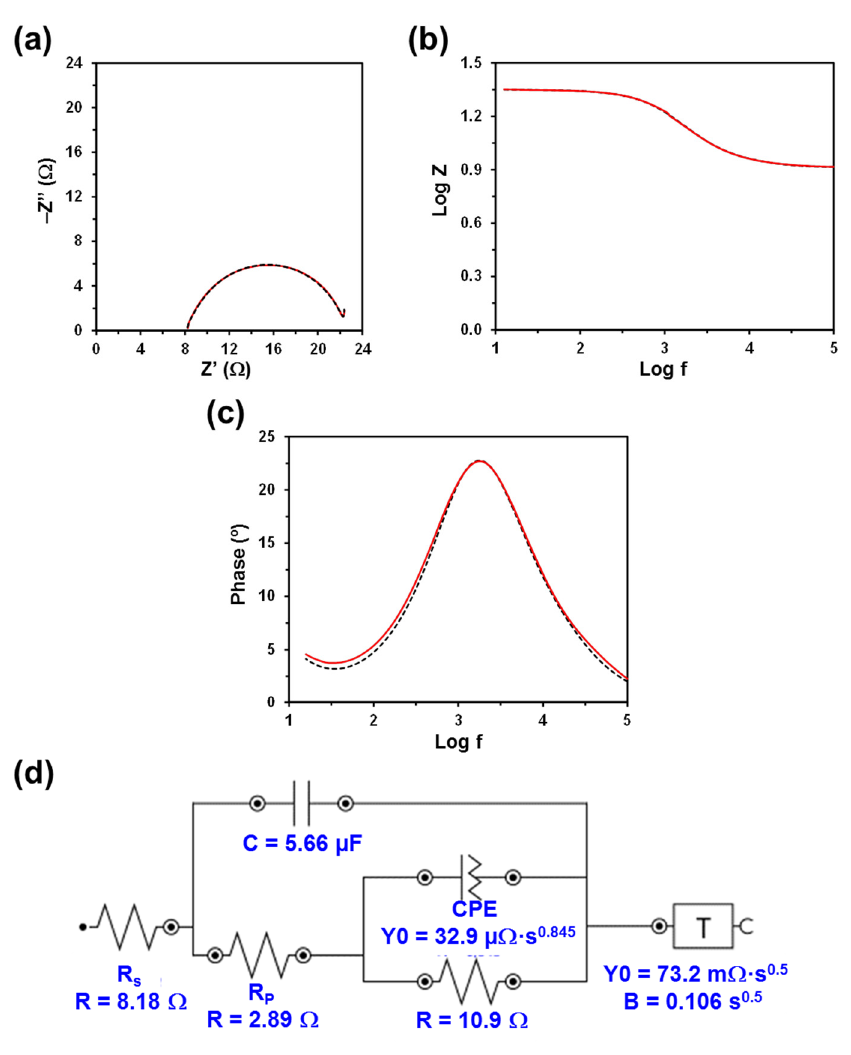
Figure 3. Measured and fitted EIS spectra (solid red line and dashed black line, respectively) for the κ C hydrogel sandwiched between two PEDOT electrodes: ( a ) Nyquist plot; ( b ) impedance Bode plot; and ( c ) phase Bode plot. ( d ) EEC model used for numerical fitting of the EIS data. Numerical results from fitting the spectra are displayed for all the elements of the EEC.